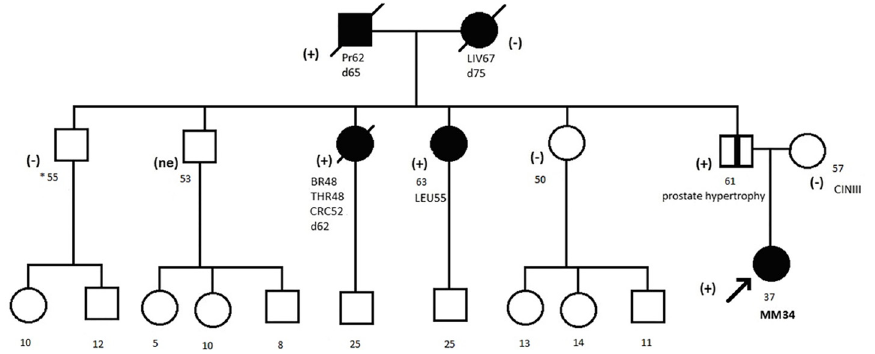
Fig 1. Pedigree of the family with c.9334G > A detected variant. (cid:3) age. Abbreviation: Pr, prostate cancer; Leu, leukemia; Br, breast cancer; Thr, thyroid cancer; CRC, colorectal cancer; Liv, liver cancer; (+), mutation positive; (-), mutation negative; (ne), not examined.